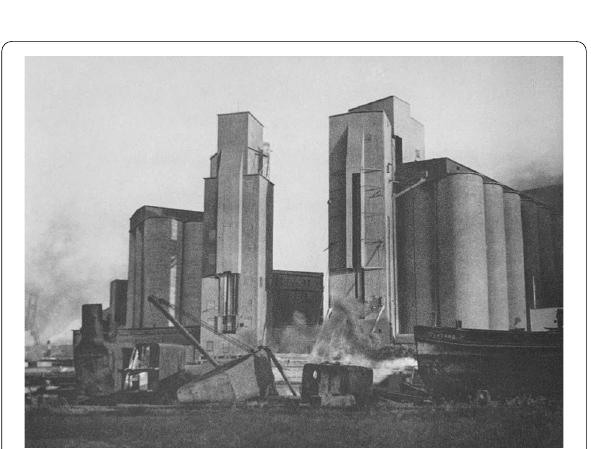
Fig. 4 Grain silos. Buffalo, New York. Erich Mendelsohn. 1926. From his book Amerika. Bilderbuch eines Architekten (Berlin: Rudolf